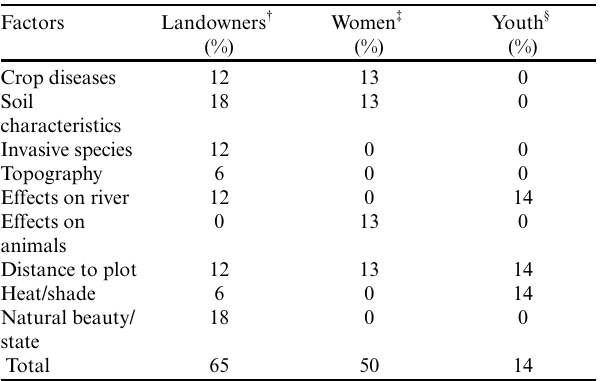
Table 4 . Ecological factors that influence land-use decisions, as mentioned by